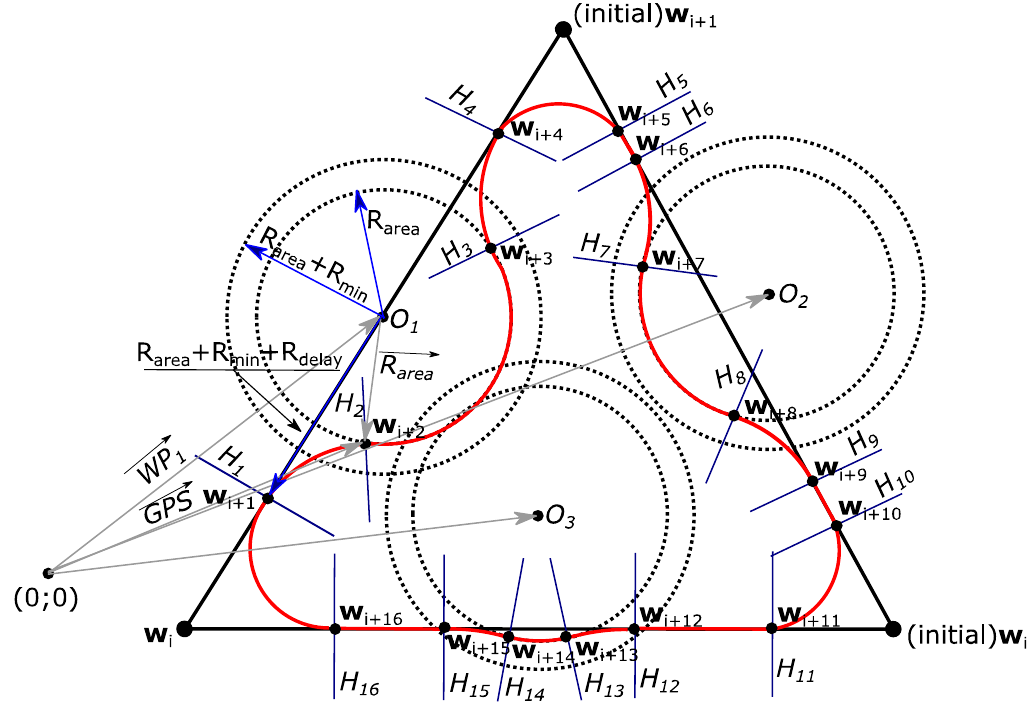
Figure 2. Flight mission with three ground obstacles that should be automatically avoided.